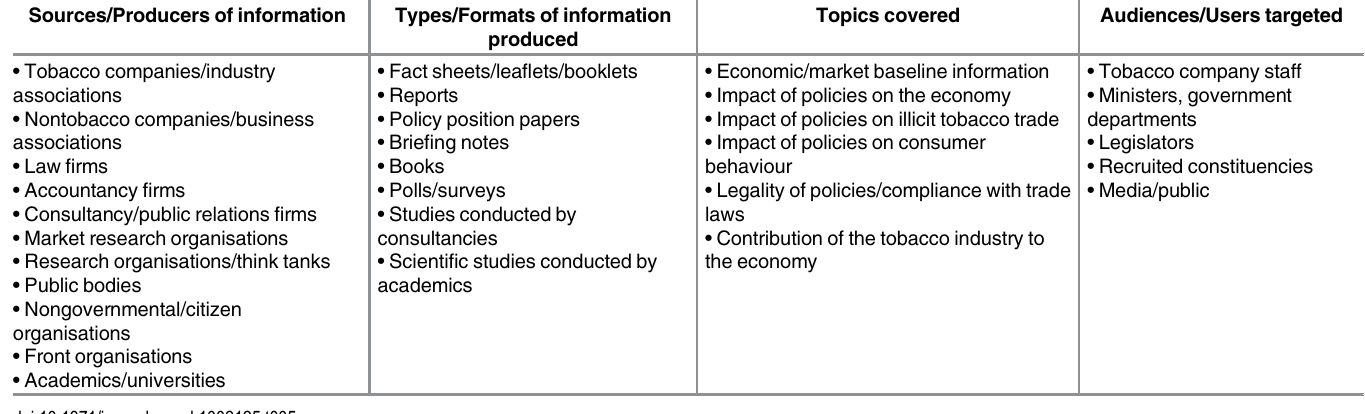
Table 5. Information management. Sources/Producers of information Types/Formats of information